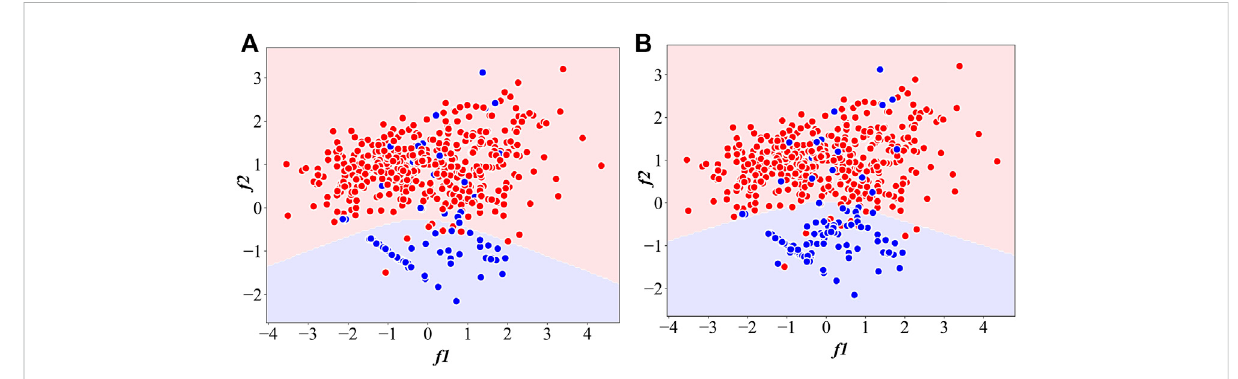
FIGURE 2 The classi fi cation (A) without processing by GSDC and (B) with processing by